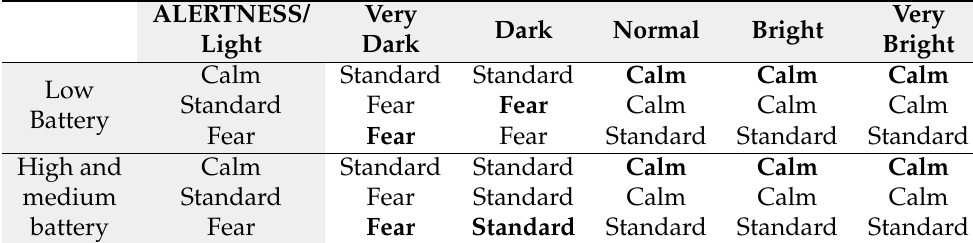
Table 5. Table of Light/ALERTNESS Rules for Low, Medium, and High Batteries. The gray cells represent the different ALERTNESS and Light labels defined. Bold respresents steady